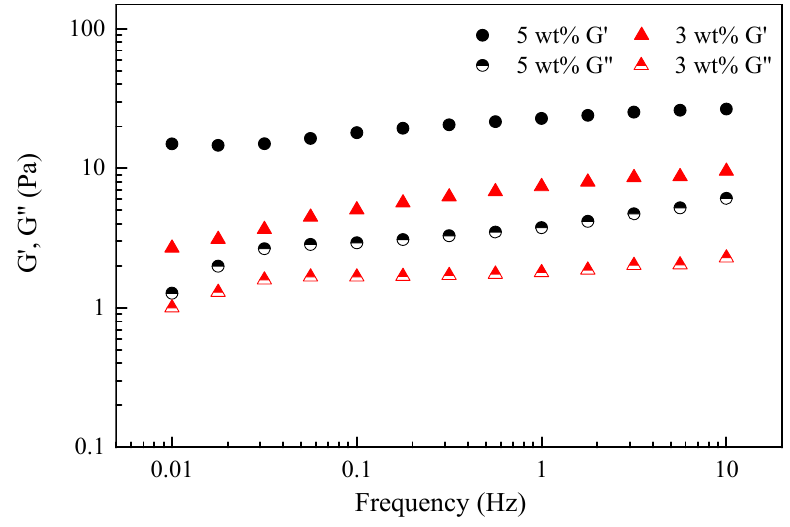
Figure 10. Storage modulus G ′ and loss modulus G ″ varying as a function of frequency for the two (3 wt % and 5 wt %) VES-T samples at 25 °C. G ′ is greater than G ″ throughout the test in both the two samples. G ′ and G ″ of the 5 wt % VES-T sample are greater than that of the 3 wt % VES-T sample.